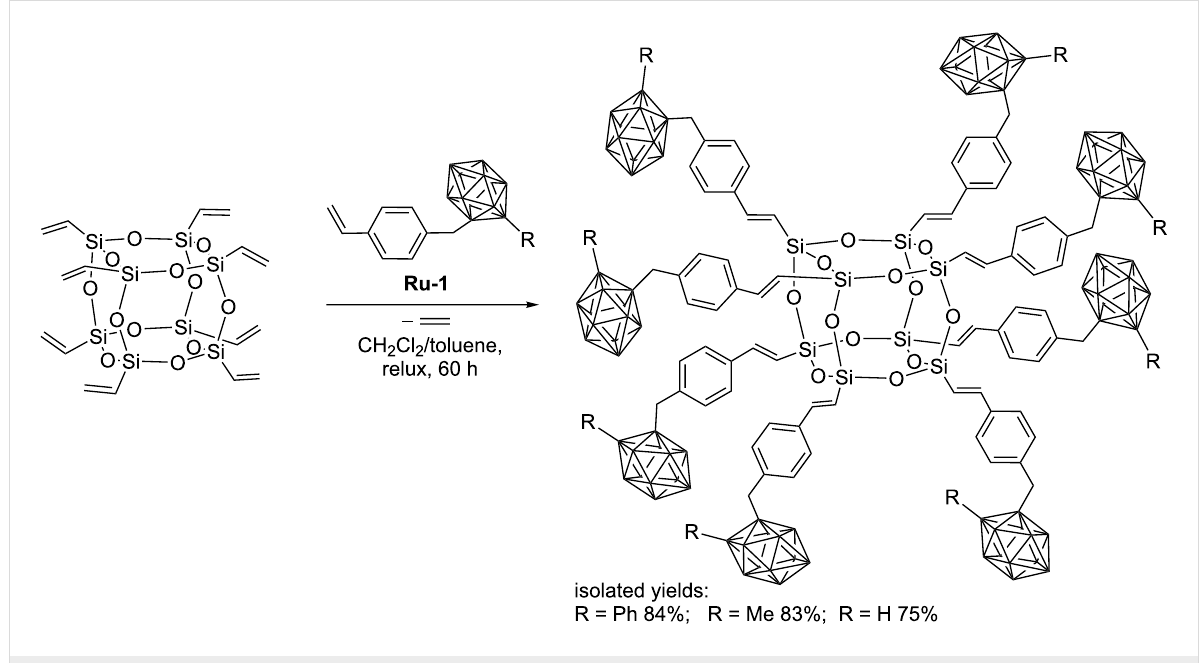
Scheme 6: Cross metathesis of OVS with carboranylstyrene.